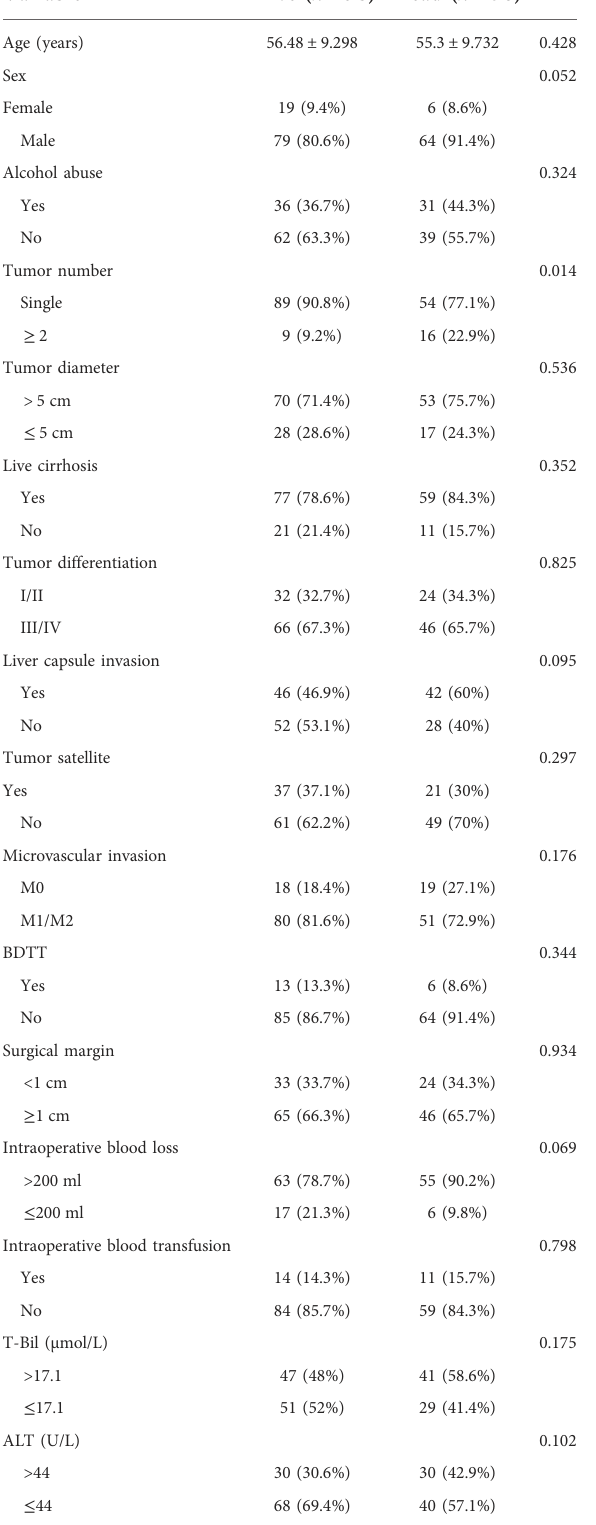
TABLE 3 Correlation of clinicopathological factors with overall survival.